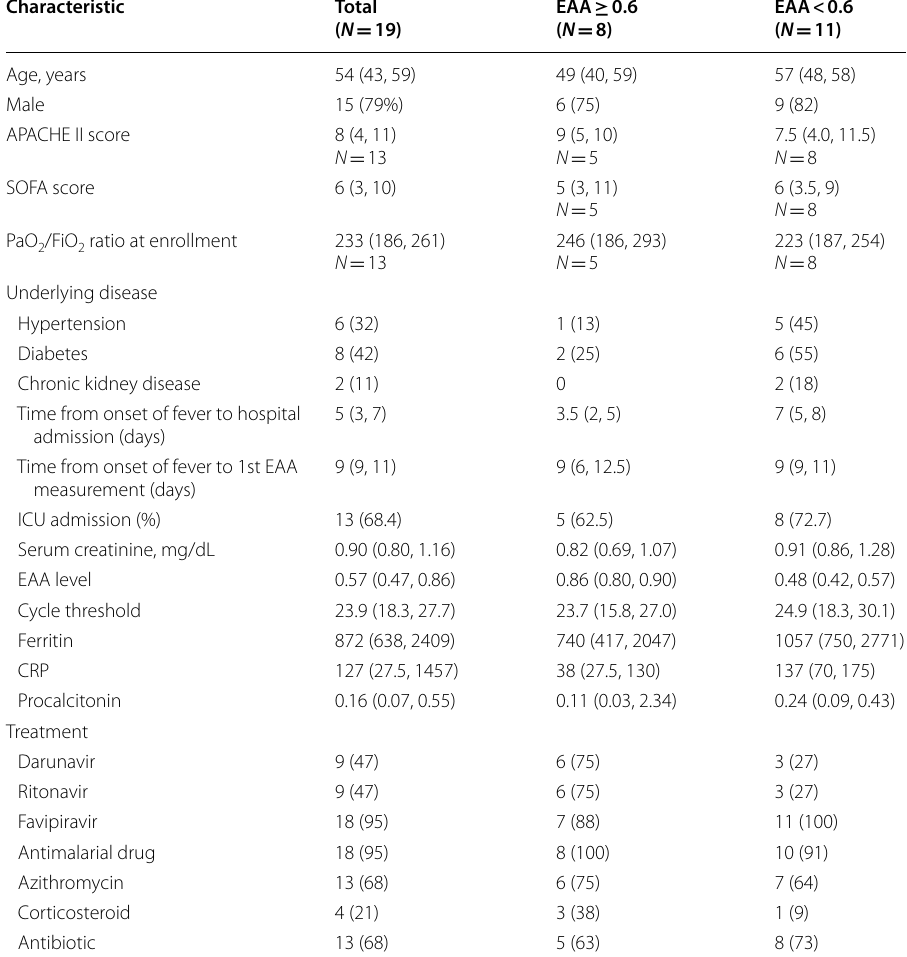
Table 1 Clinical characteristics of COVID-19 pneumonia at